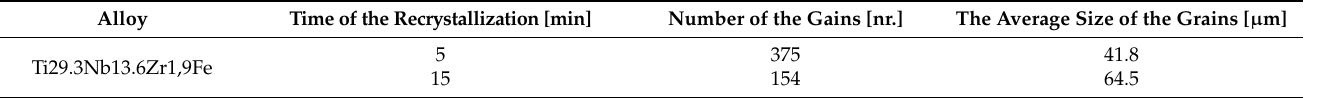
Table 5. The number of grains and their size distribution in the Ti29.3Nb13.6Zr1.9Fe alloy. Alloy Time of the Recrystallization [min] Number of the Gains [nr.] The Average Size of the Grains [ µ m]